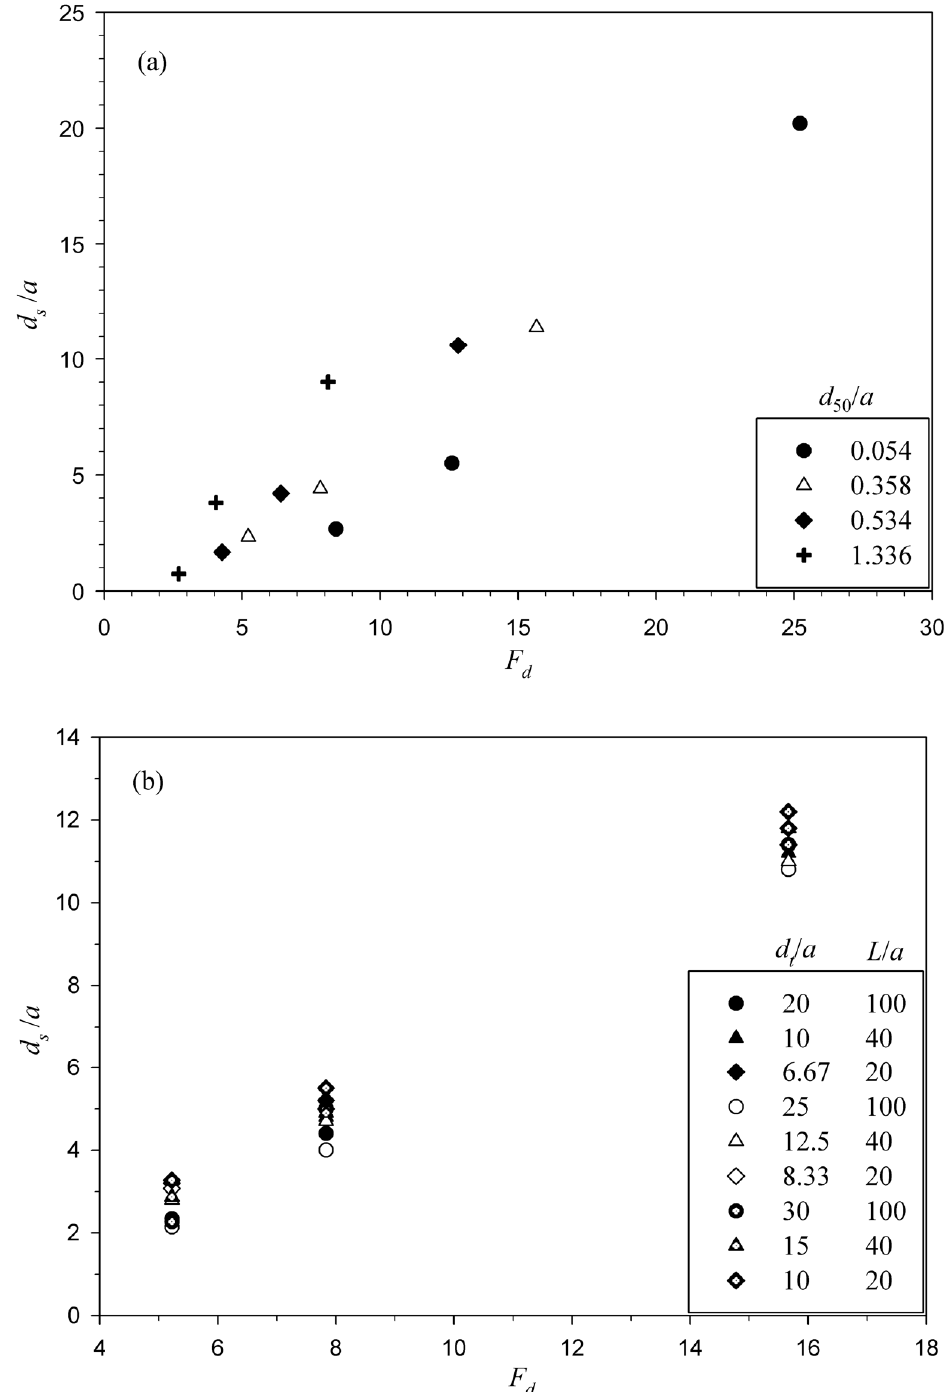
Figure 7. d s / a variation with F d for various ( a ) d 50 , and ( b ) d t , and L. Figure 8 shows the variation of normalized equilibrium scour depth d s / a on tailwater level/sluice opening ratio d t / a for different Froude numbers F and sediment sizes d 50 . A drooping nature is seen for the variation of d s / a with d t / a . It shows that a critical level of tailwater exists corresponding to the minimum d s / a [11,15]. A comparison between